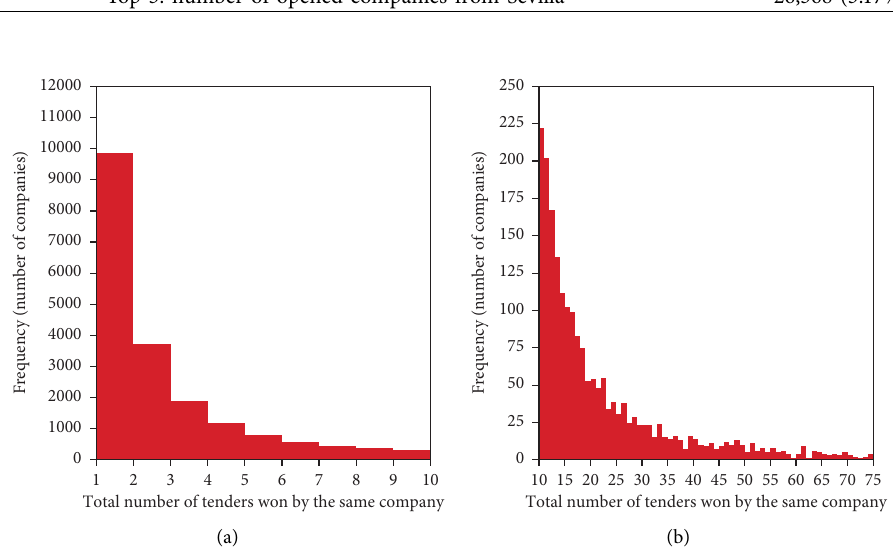
Figure 3: Histogram of frequency (number of companies) based on the total number of tenders in the dataset won by the same company (bidder). The graph is divided into two for better